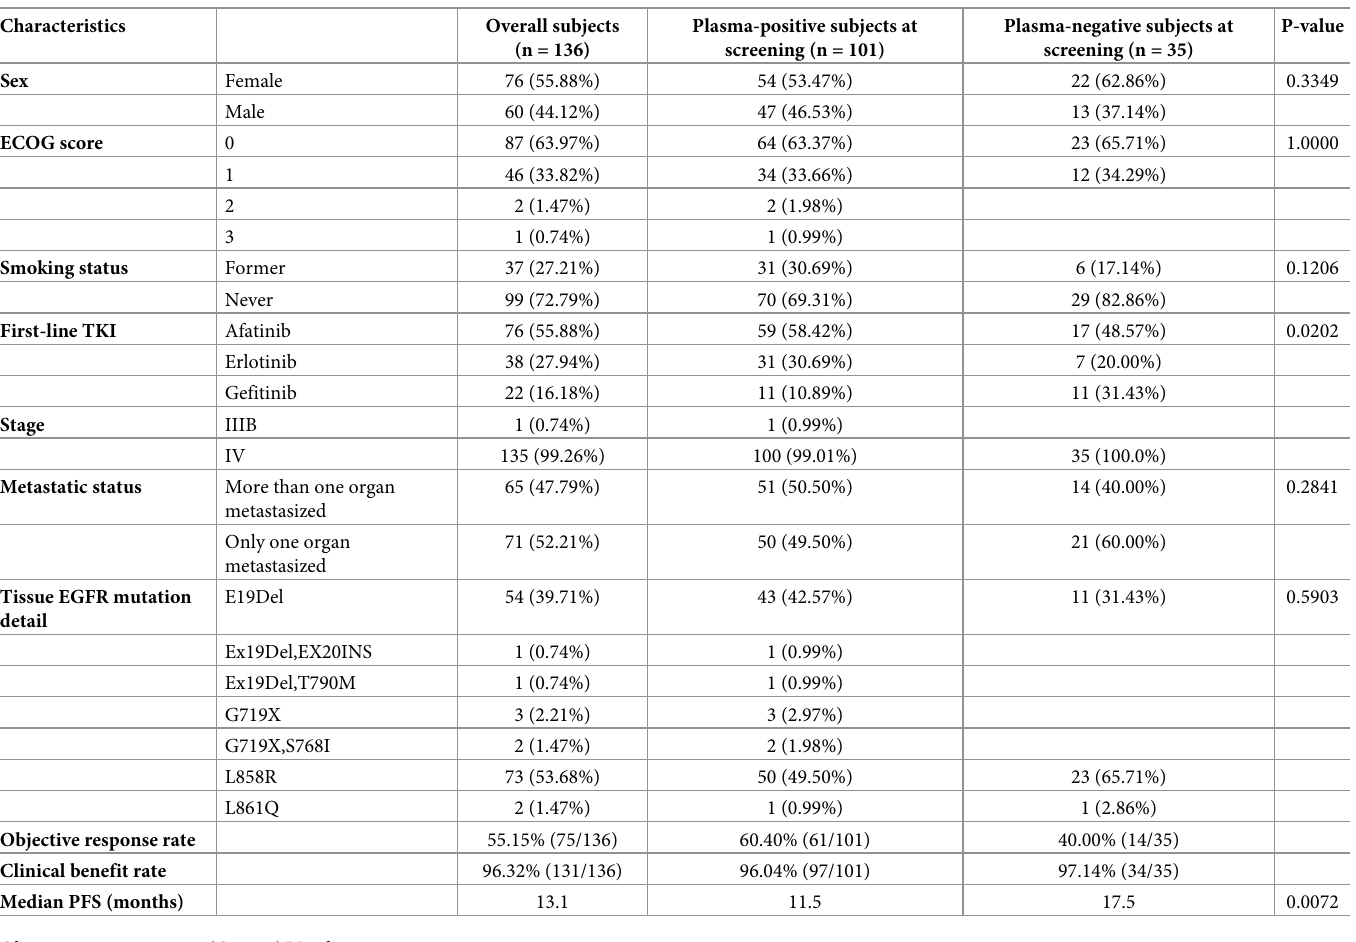
Table 1. Patient demographics and baseline clinical characteristics by EGFR mutation status.